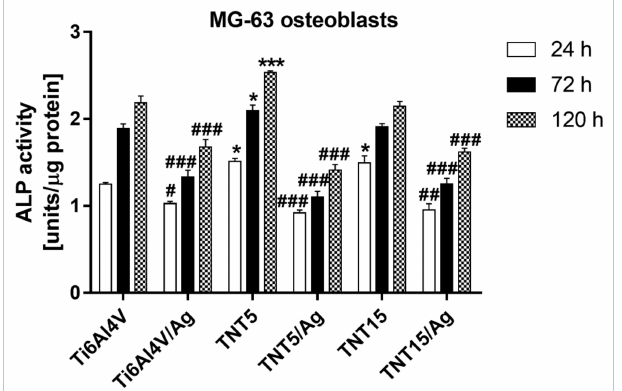
Figure 4. Alkaline phosphatase activity (ALP) of MG-63 osteoblasts growing on TiO 2 nanotube coatings produced by electrochemical anodic oxidation at potentials of 5 (TNT5) or 15 V (TNT15) and enriched with silver nanoparticles in comparison with the reference Ti6Al4V alloy foils and enriched or not with silver nanograins. The cells were cultured on the surface of the tested specimens for 24, 72, and 120 h. ALP activity [units] was calculated per µ g of protein and it is expressed as the means ± SEM of five independent experiments. Asterisks indicate significant di ff erences at the appropriate incubation time when the ALP activity of the cells growing on the tested specimens was higher compared to the reference Ti6Al4V alloy foils (Ti6Al4V) (*** p < 0.001, * p < 0.05). Hash marks denote significant di ff erences at the appropriate incubation time when the ALP activity of osteoblasts cultivated on the tested samples was lower in comparison with the reference Ti6Al4V alloy foils (### p < 0.001, ## p < 0.01, # p <